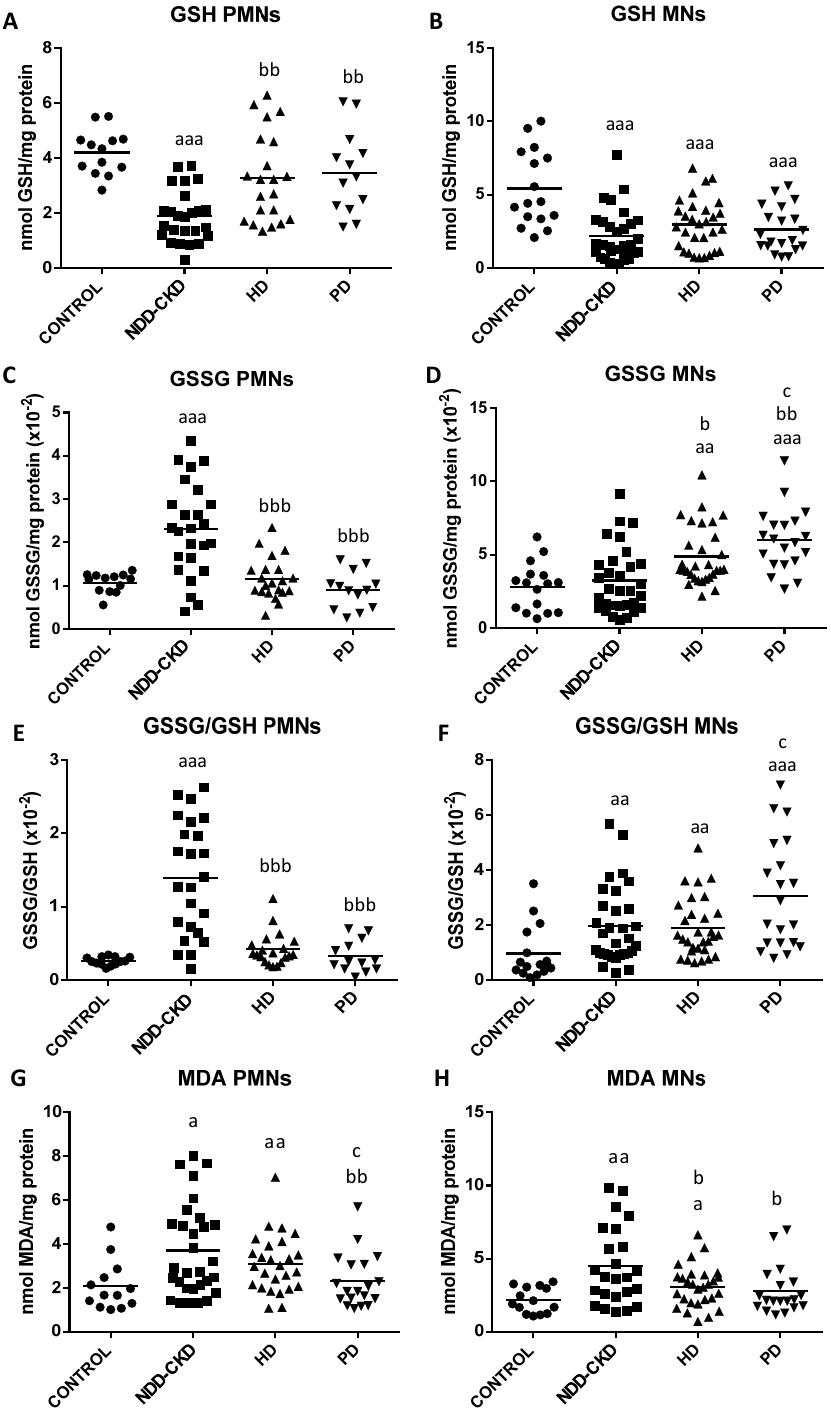
Figure 3. Intracellular glutathione balance and lipid damage in isolated peripheral blood polymorphonuclear (PMNs) and mononuclear (MNs) leukocytes from healthy subjects (control), non-dialysis-dependent chronic kidney disease (NDD-CKD), hemodialysis (HD) and peritoneal dialysis (PD) patients. ( A ) PMNs and ( B ) MNs reduced glutathione content (GSH; nmol/mg protein); ( C ) PMNs and ( D ) MNs oxidized glutathione content (GSSG; nmol/mg protein); ( E ) PMNs and ( F ) MNs GSSG/GSH ratio. ( G ) PMNs and ( H ) MNs malondialdehyde content (MDA; nmol/mg protein). Data are shown as the mean (horizontal bar) of 13–39 values corresponding to the number of subjects analyzed in each group. Each value is the mean of duplicate assays. a p < 0.05, aa p < 0.01 and aaa p < 0.001 versus control; b p < 0.05, bb p < 0.01 and bbb p < 0.001 versus NDD-CKD patients; c p < 0.05 versus HD